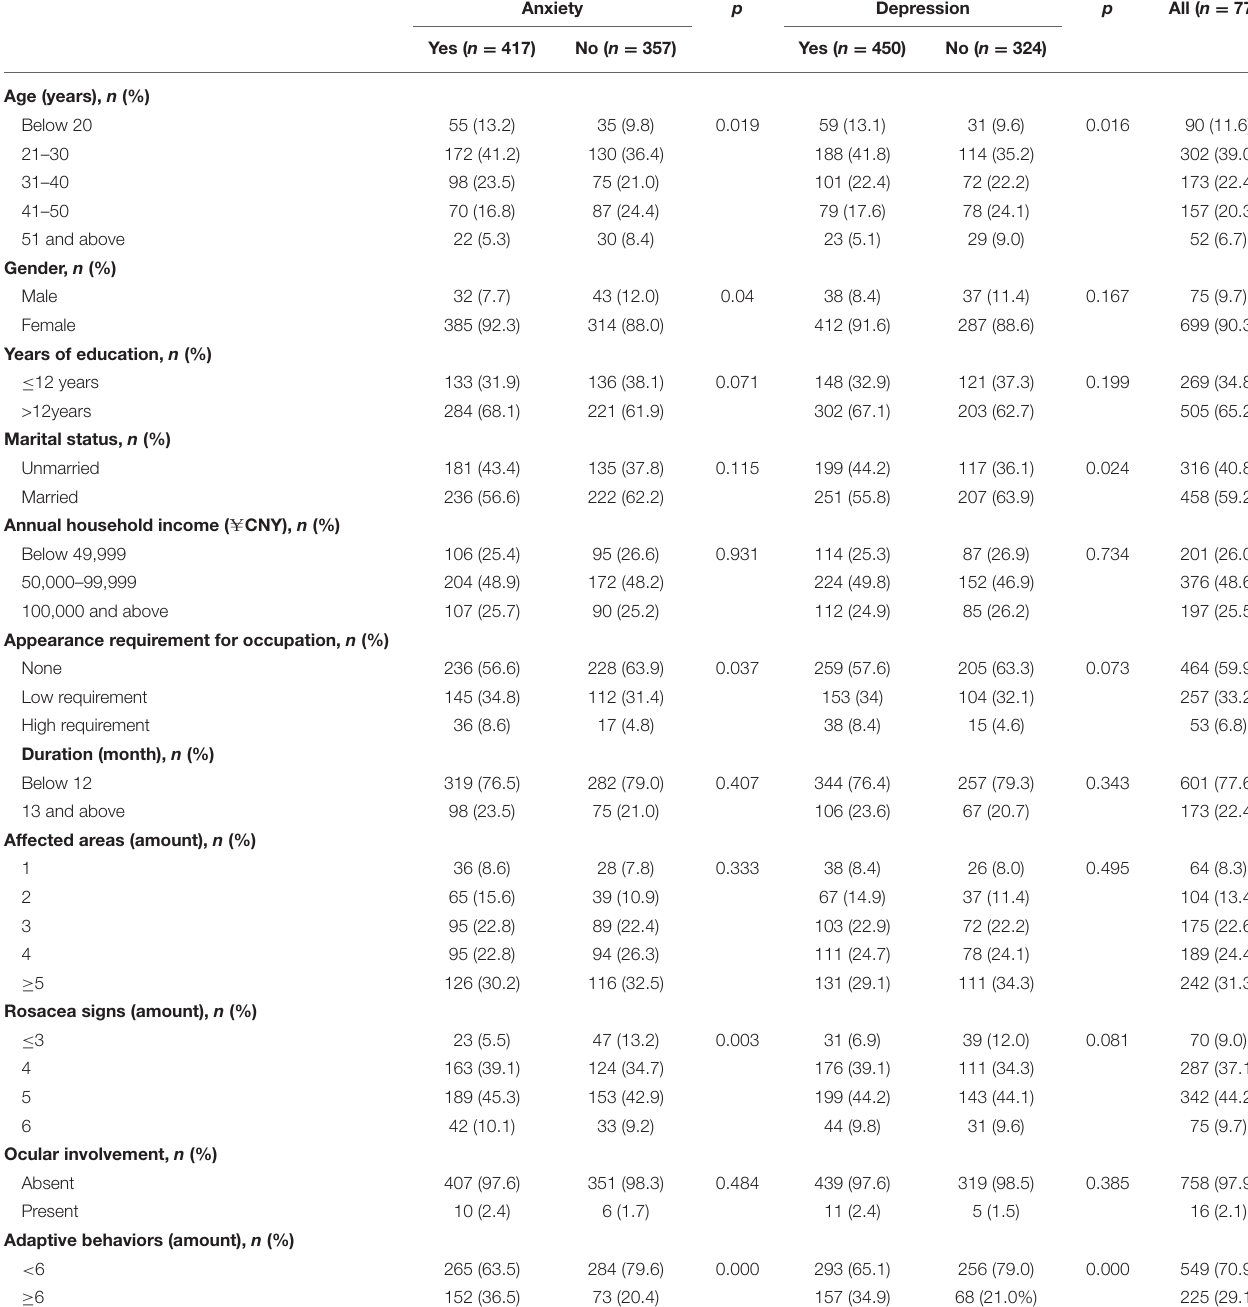
TABLE 1 | Demographic and clinical factors associated with anxiety or